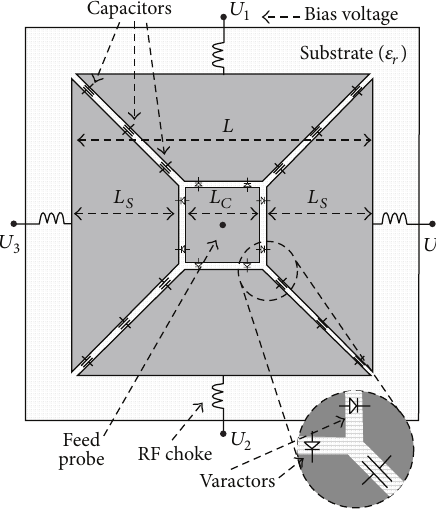
Figure 6: Varactor-loaded patch antenna [13].